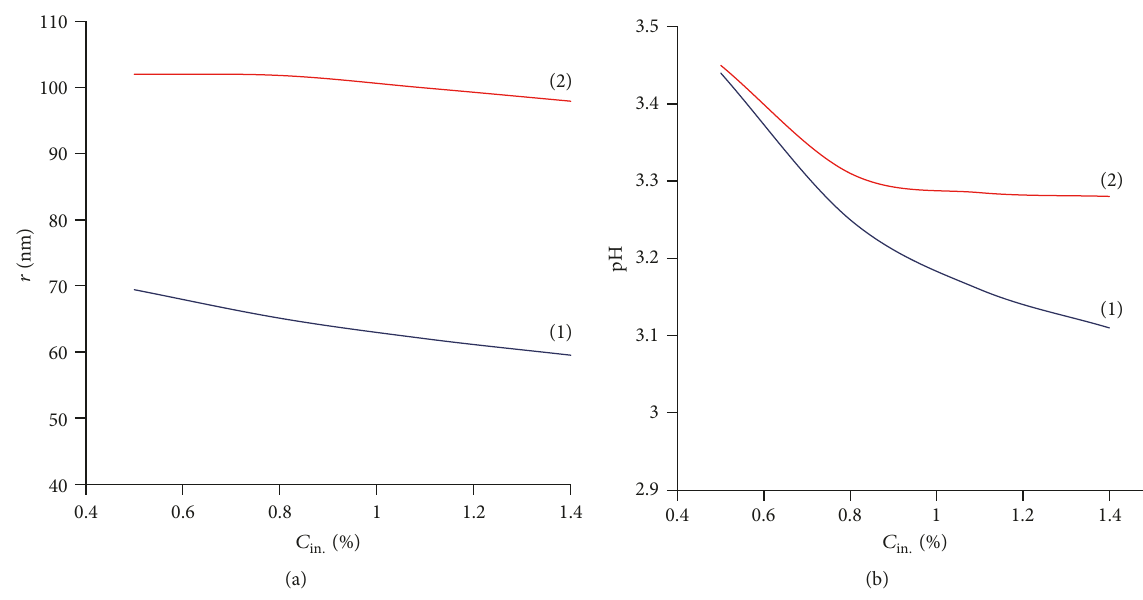
Figure 3: Influence of synthesis conditions on the properties of copolymer latexes: (a) 𝑟 ; (b) aX . (1) 323 K; (2) 333 K.